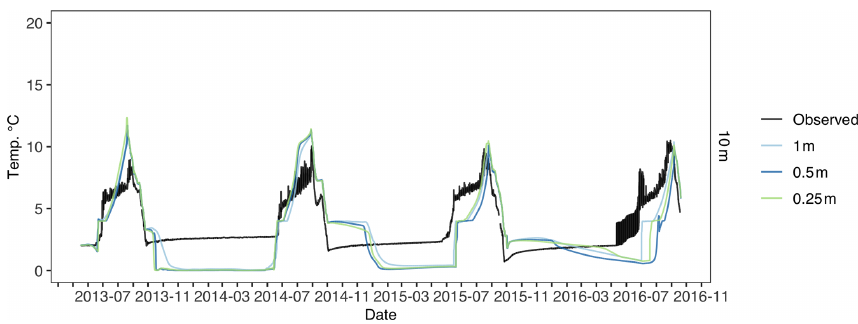
Figure D7. Toolik 10m water temperature across different water vertical resolution simulations. Observed water temperature is in black, 1m vertical resolution is in light blue, 0.5m vertical resolution is in blue, and 0.25m vertical resolution is in green.